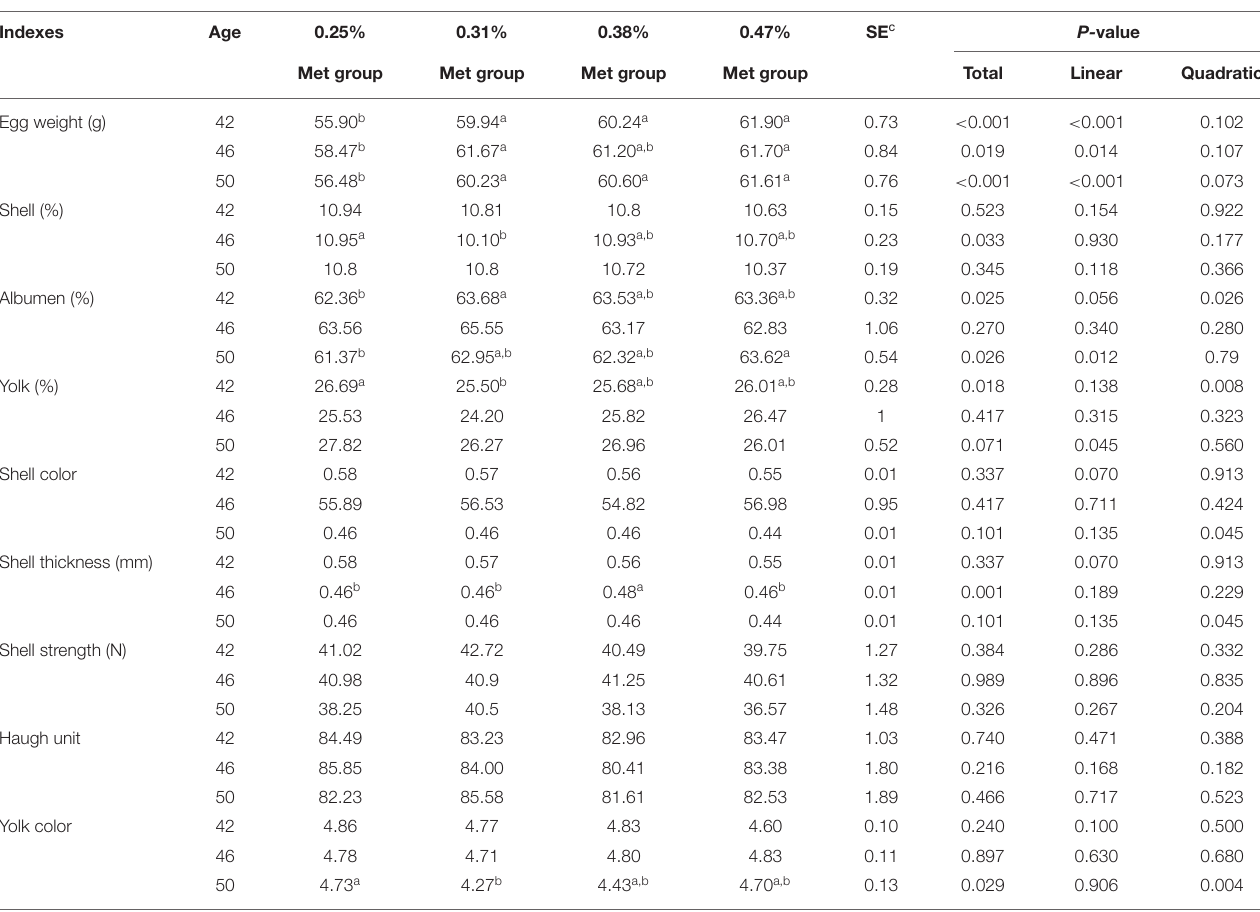
TABLE 2 | The effects of different dietary met supplementation in low protein diets on the egg quality of 42-, 46-, and 50-week-old laying hens.